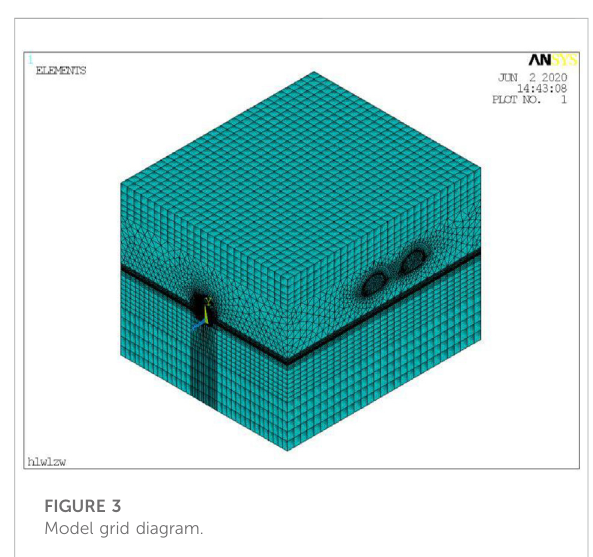
FIGURE 3 Model grid